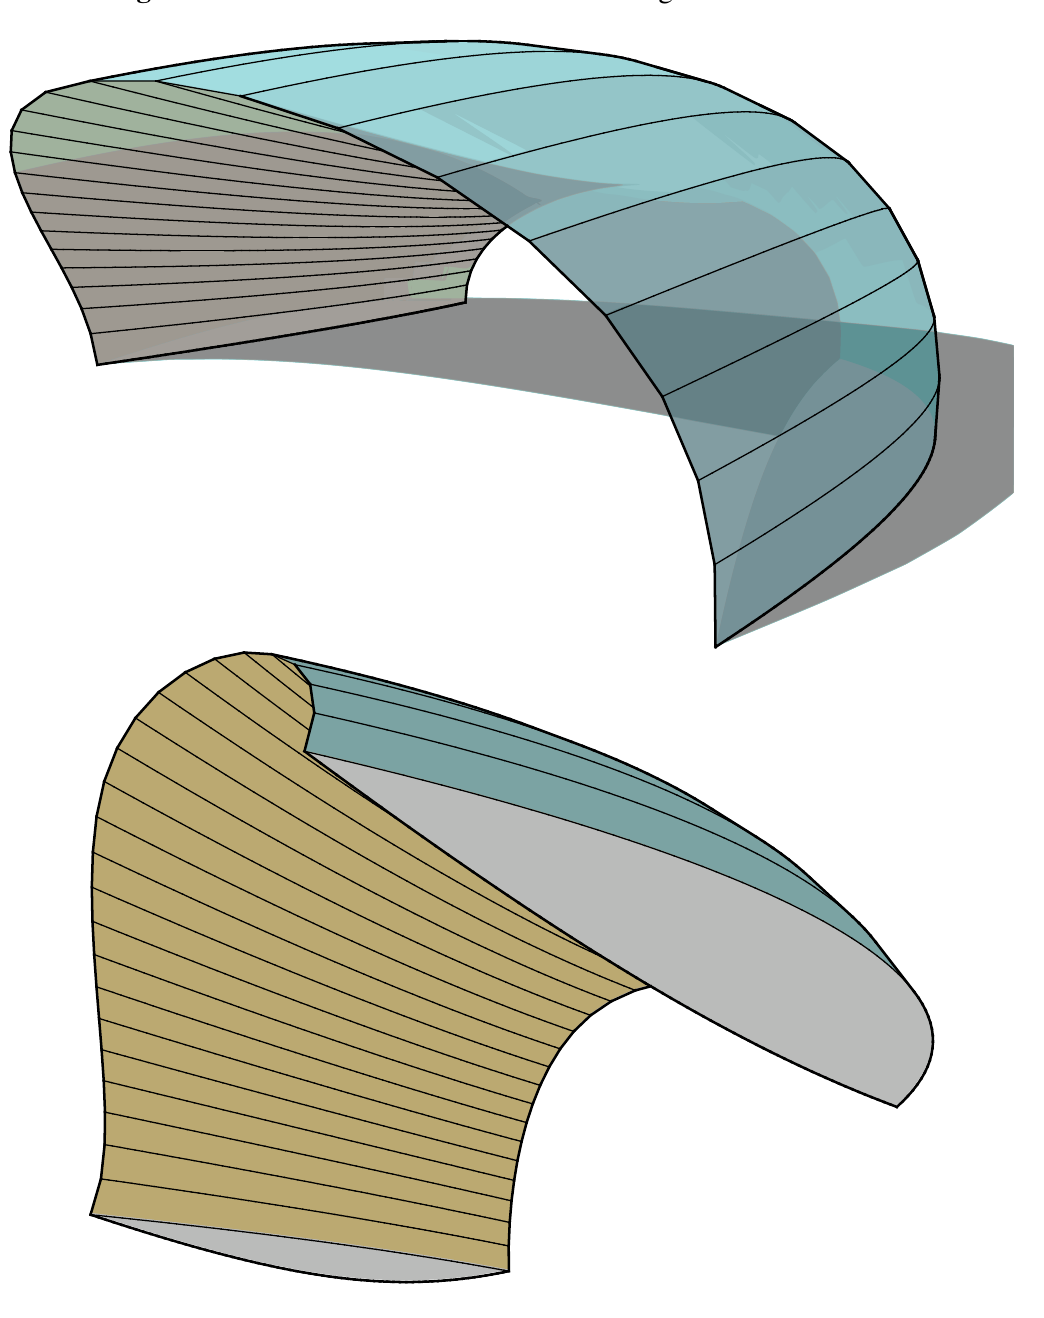
Figure 35. Two method three surfaces forming a hollow shell arch.